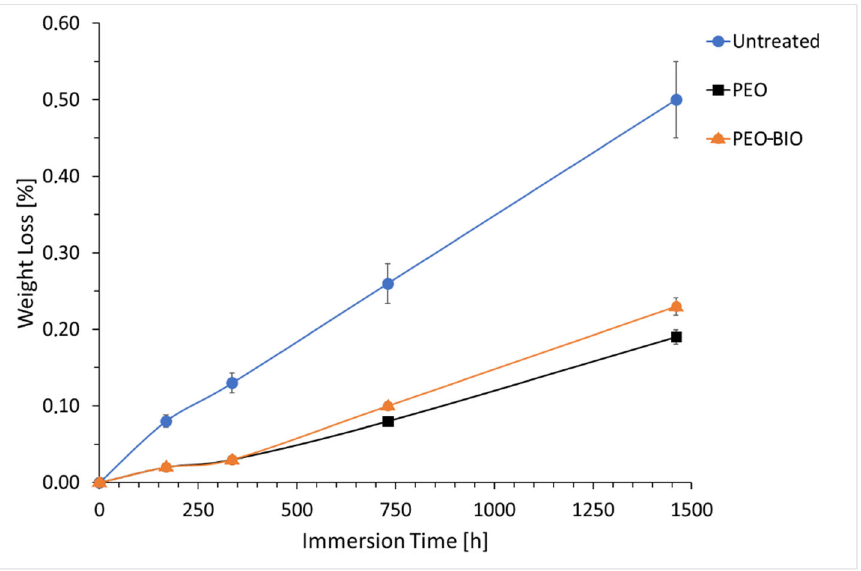
Figure 7. Results of the weight loss measurements of the different samples. Test electrolyte: simulated body fluid at 37 °C.